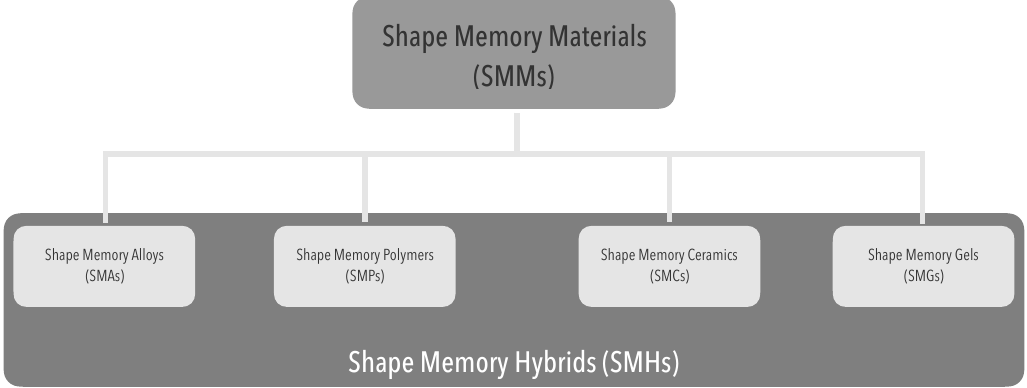
Figure 4. Shape-memory polymers within the shape-memory materials